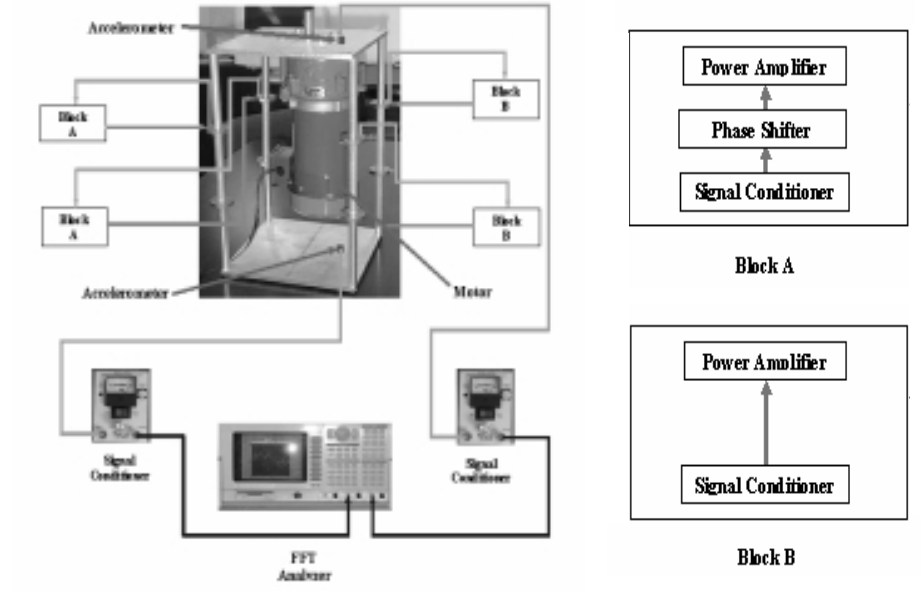
Fig. 9. Experimental setup used to demonstrate the feasibility of using the tunable mechanical filter to isolate the vibrations induced by the motor.